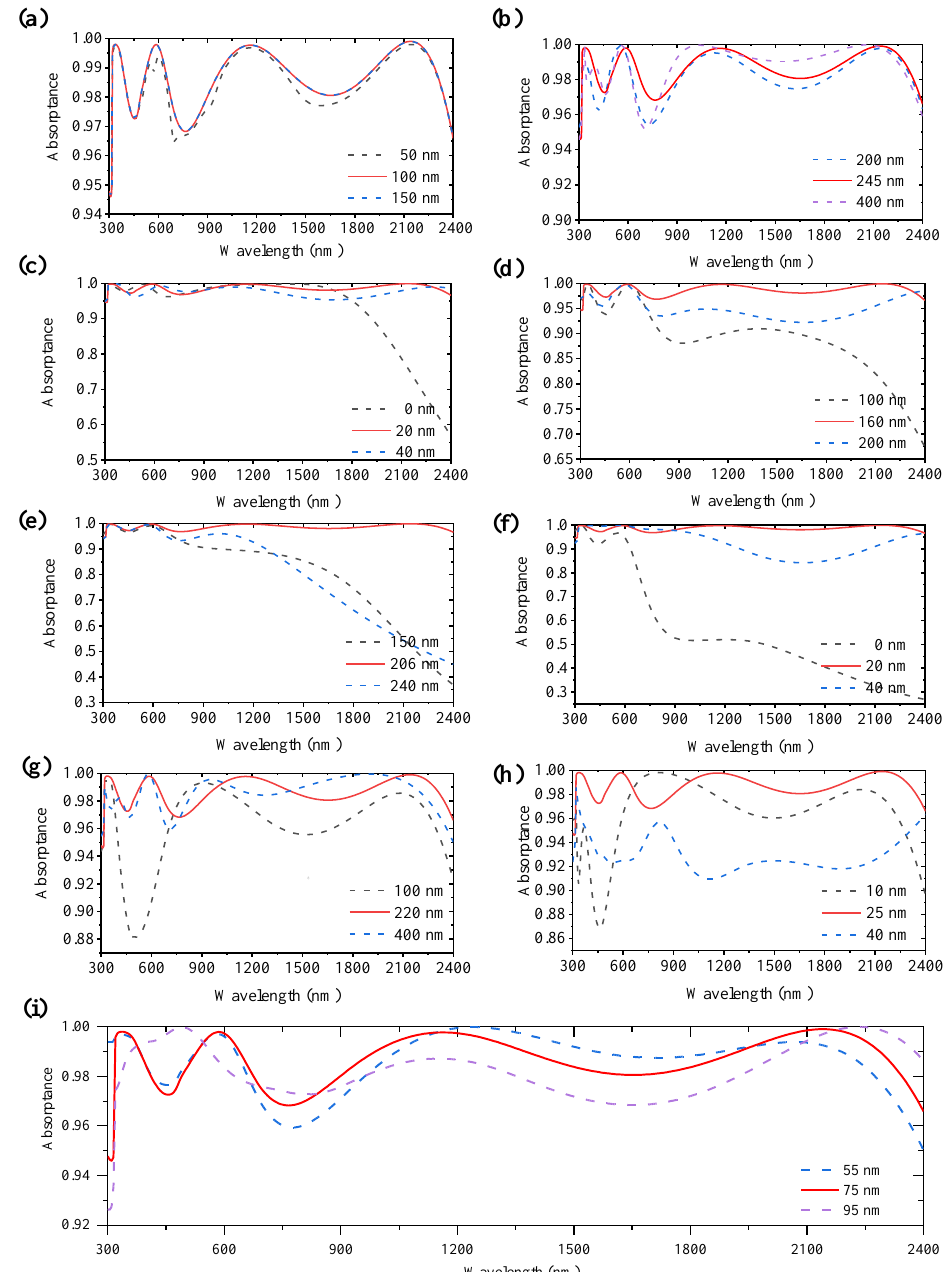
Figure 8. The absorption spectra of the proposed absorbers with different geometric parameters. ( a ) The thickness of the Ag layer. ( b ) The thickness of the SiO 2 layer. ( c ) The thickness of the Al 2 O 3 layer. ( d ) The height of the cross structure. ( e ) The length of the cross nanostructures. ( f ) The width of the cross nanostructures. ( g ) The height of the nano-cylinders. (h ) The radius of the nano-cylinders. ( i ) The coordinate distances ( x and y ) between the bottom center of the nano-cylinders and the x and y axes.